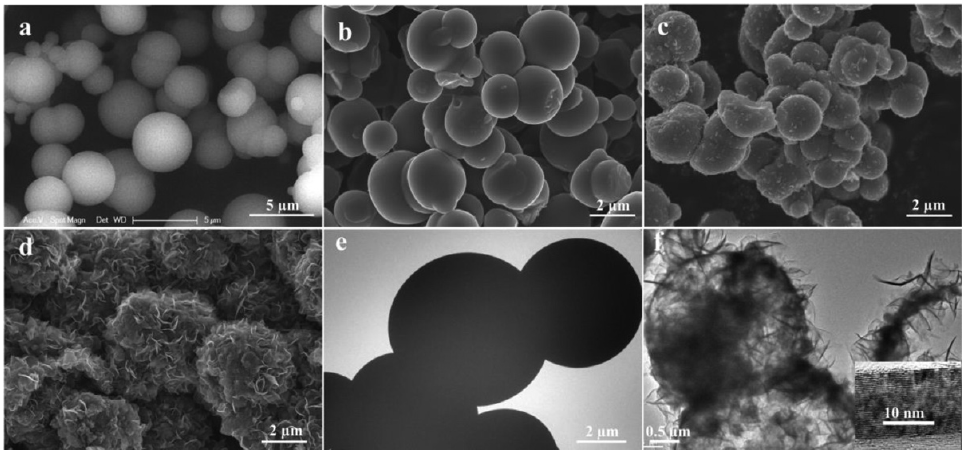
Figure 14. ( a – d ) SEM images of AMC before ( a , b ) And after ( c , d ) The electrochemical graphitization at 820 °C. ( a ) Raw; ( b ) Immersed in the melt for 2 h; ( c ) 0.45 V for 0.25 h; ( d ) 0.45 V for 2 h; ( e , f ) TEM images of AMC; ( e ) And the graphitized AMC at 820 °C and 0.45 V for 2 h. Reproduced with permission from Chunyan Zhang, Glucose-derived hollow microsphere graphite with a nanosheets- constructed porous shell for improved lithium storage; published by Elsevier, 2021 [131].